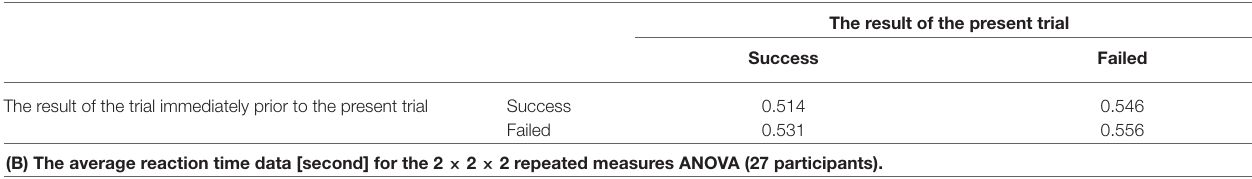
TABLE 1 | The average reaction time (RT) for each trial